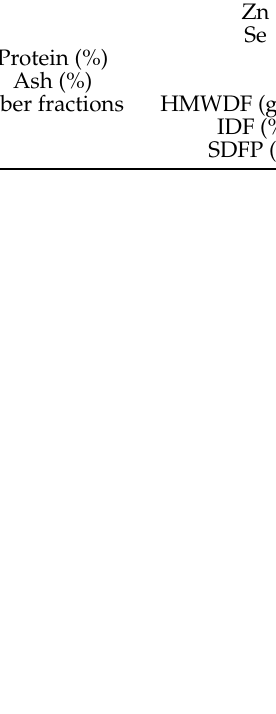
Table 4. Nutritional values for Ctrl, CP, GFB5, GFB6 and